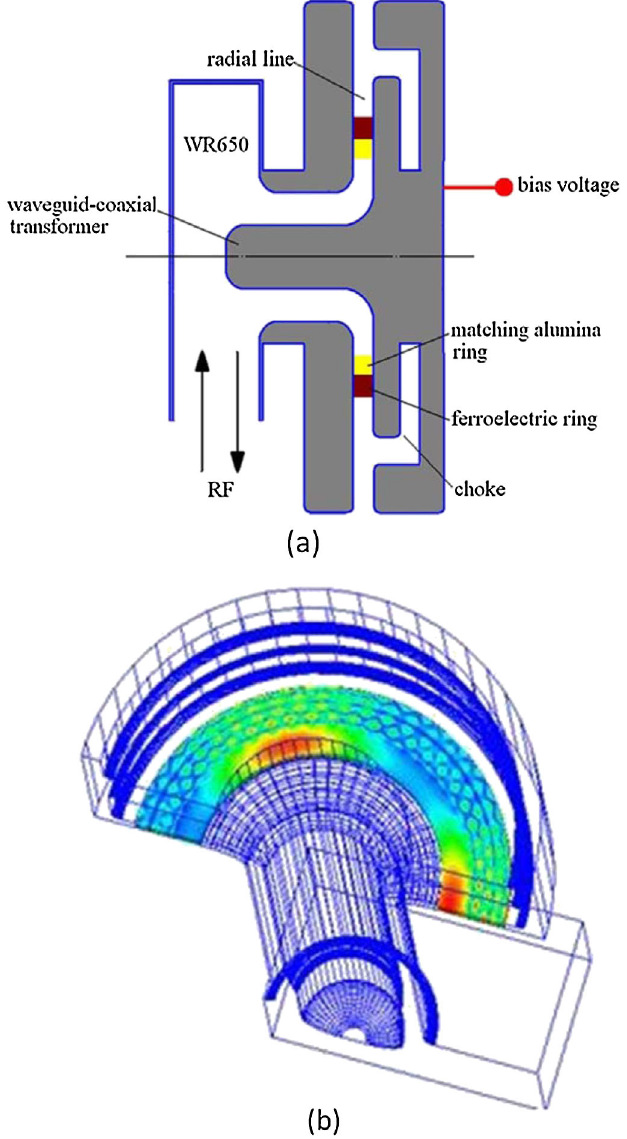
FIG. 13. (a) Planar-coax version (it is about 22 cm in diameter and 12 cm wide); and (b) example of a parasitic mode in the planar-coax